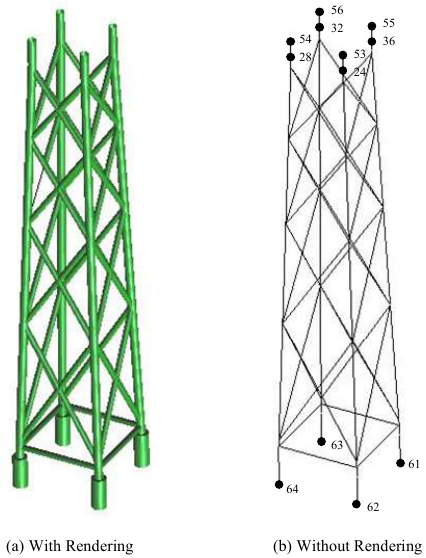
Figure 4. NREL 5MW jacket support structure model.